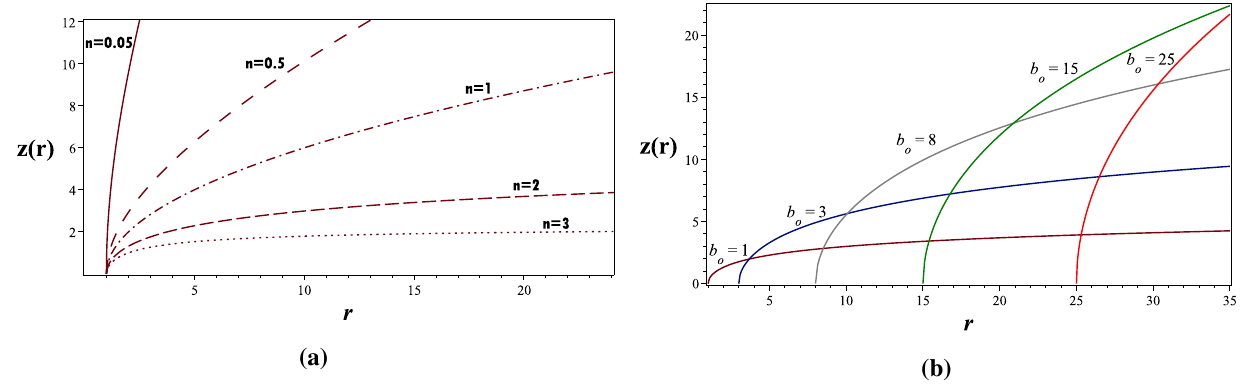
Fig. 2 a The plot shows a visualization of the wormhole for different values of the shape exponent ( n ). b The plot shows a visualization of the wormhole for different values of the throat radius ( b o )